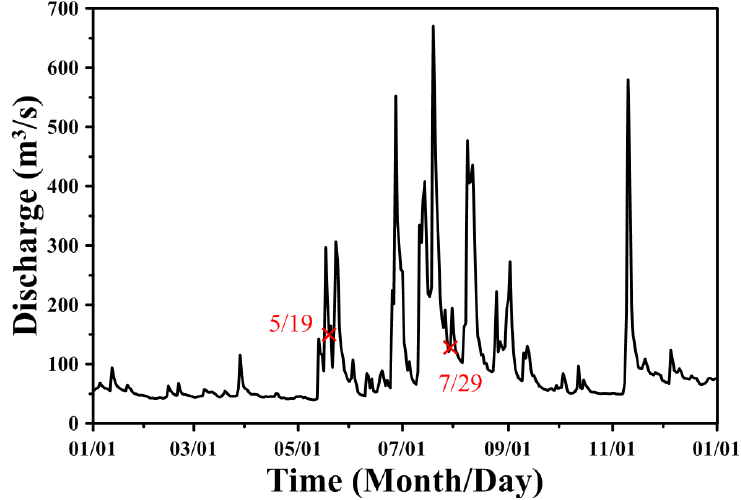
Figure 4. Freshwater discharge inputs at the Dadu Bridge in 2011.